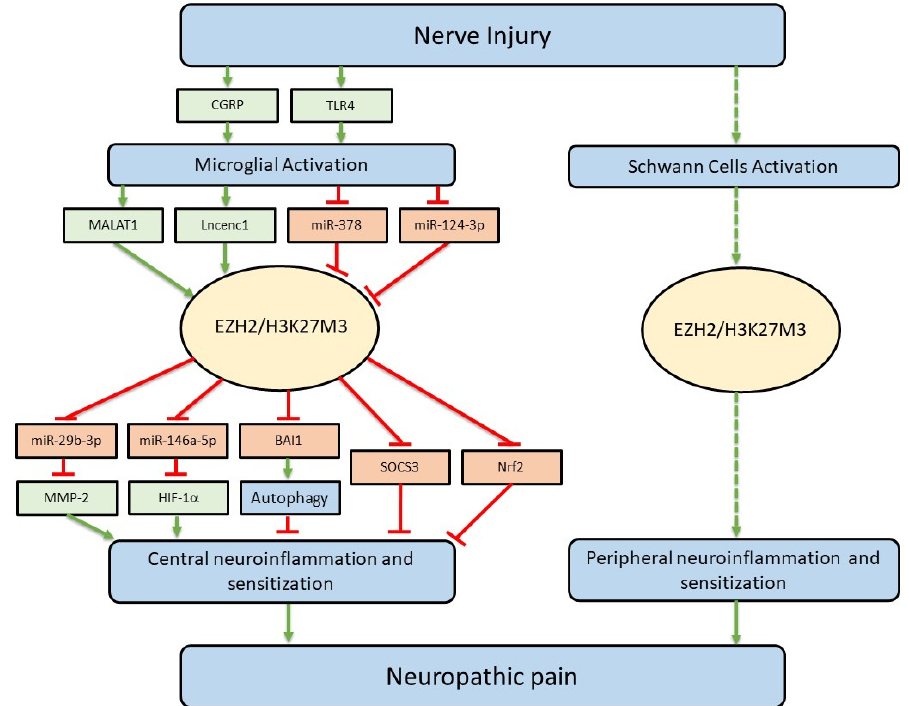
Figure 3. The EZH2 signaling pathway in the regulation of neuroinflammation and neuropathic pain. Upstream signaling molecules regulating EZH2 protein expression and function and downstream signaling molecules used by EZH2 in microglia (left) are shown. The EZH2 signaling pathways in Schwann cells (right) remain unknown (shown in dash line). Genes with expression or activity that is enhanced are indicated in green, while genes with expression or activity that is suppressed are in red.